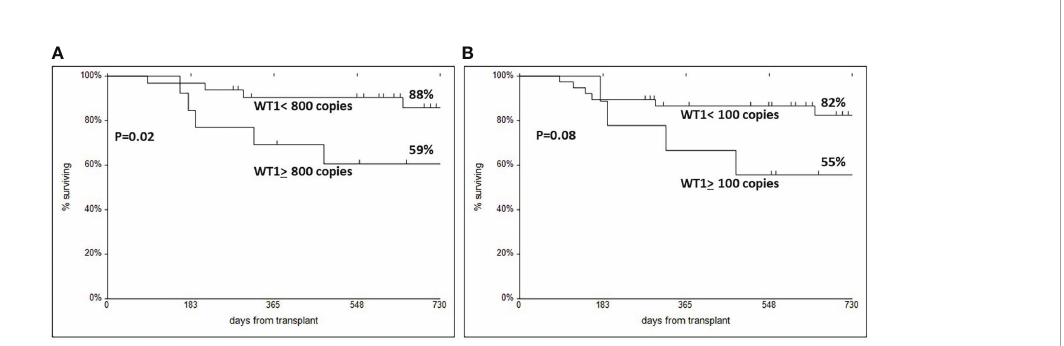
FIGURE 4 Actuarial two year survival in patients with a cut off of WT1 800 copies for CD34 selected BM cells (A) , or WT1 100 copies for unfractionated BM cells (B) .